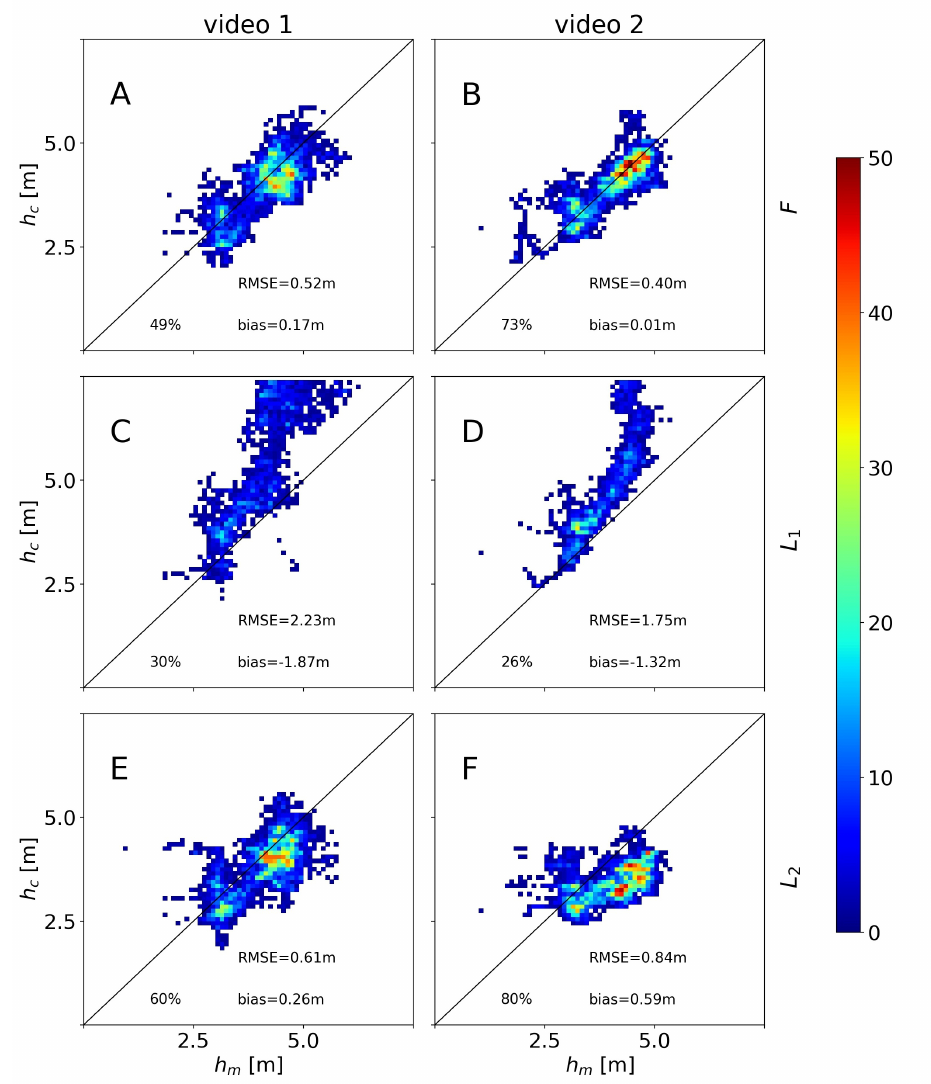
Figure 13. Scatter plot of ground truth ( h m ) and computed ( h c ) water depths for different sets of intrinsic parameters for ε (cid:54) ε 0 . Results for video 1 ( A , C , E ) and video 2 ( B , D , F ) and for intrinsic calibrations F ( A , B ), L 1 ( C , D ) and L 2 ( E , F ). The plots include the percentage of points of the original domain that are retrieved, as well as the RMSE and